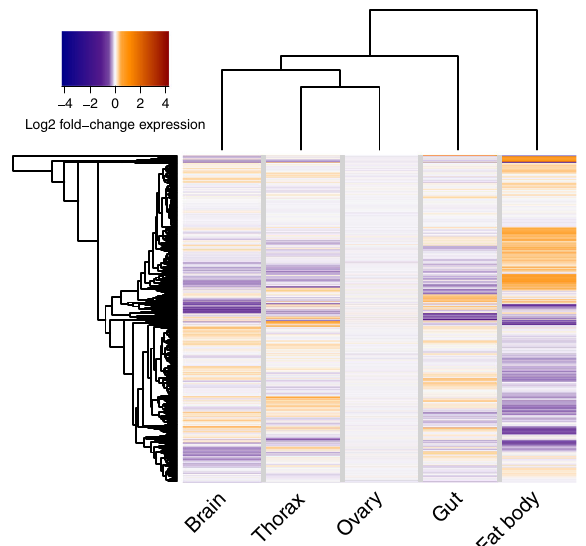
Fig. 1 Tissue-speci fi c transcriptomic signatures of DR. The heatmap shows transcriptome-wide log 2 fold-changes in gene expression induced by DR in each tissue, relative to the EAA-replete control condition. Dendrograms show hierarchical clustering by Euclidian